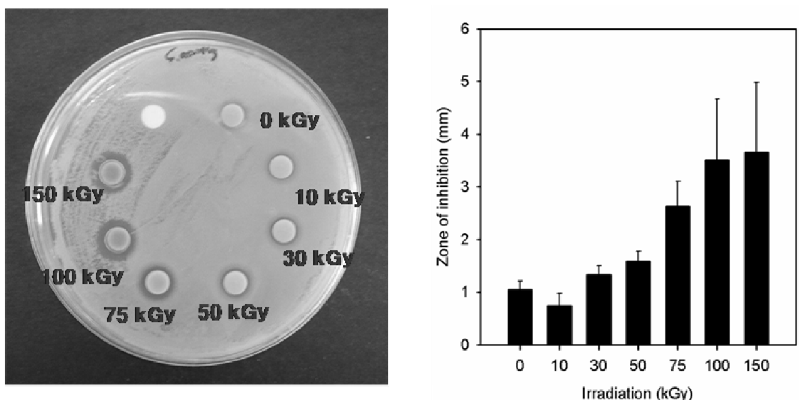
Figure 9. Zone of inhibition of silver nanoparticles against Staphylococcus aureus ; PAAc 1 wt%, Hexane 3 wt%, AgNO 0.005 M. 3